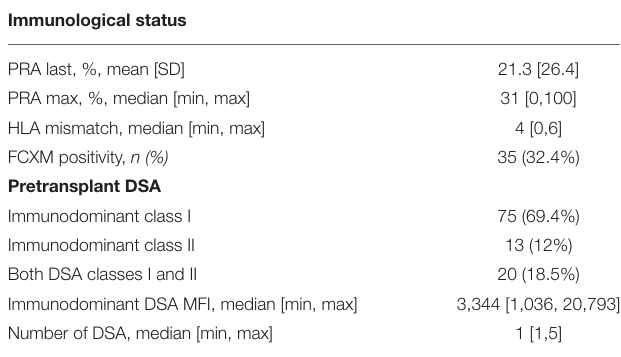
TABLE 2 | Immunological characteristics of human leukocyte antigen incompatible kidney transplant recipients.